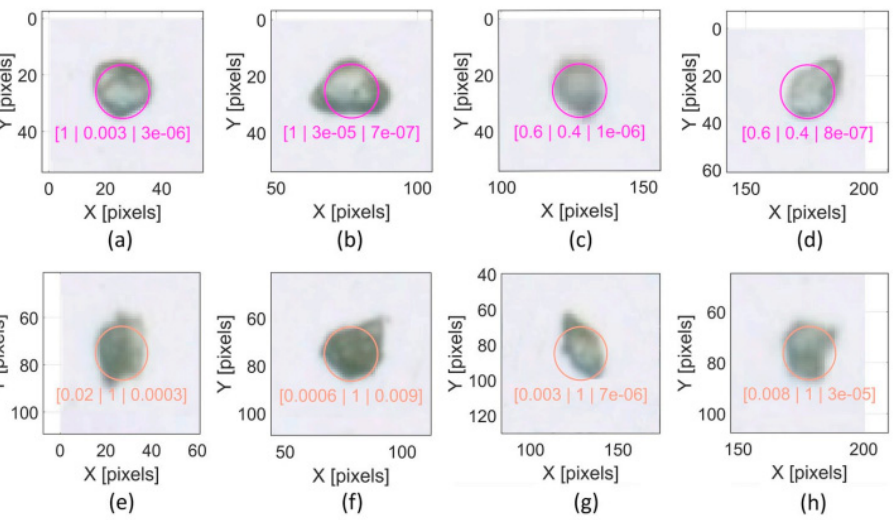
Figure 5. Proppant (subplots a, b, c, & d) and natural calcite (subplots e,f,g,& h) particles highlighted with results from classifier applications. Reprinted with permission from [8], copyright Debotyam Maity and Jordan Ciezobka,